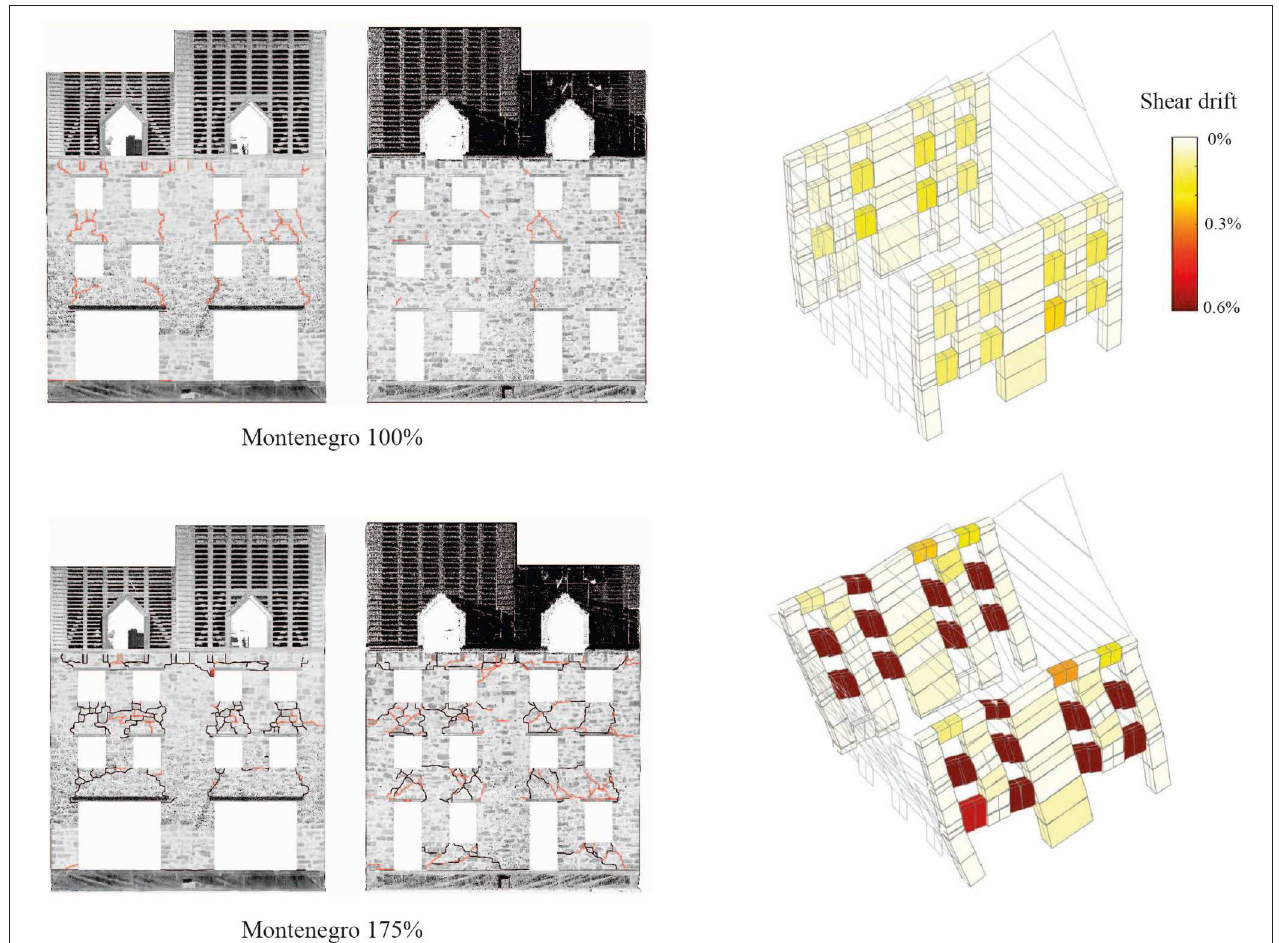
FIGURE 9 | Stone masonry building: comparison between experimental crack patterns and shear drifts in the elements after Montenegro 100% and Montenegro